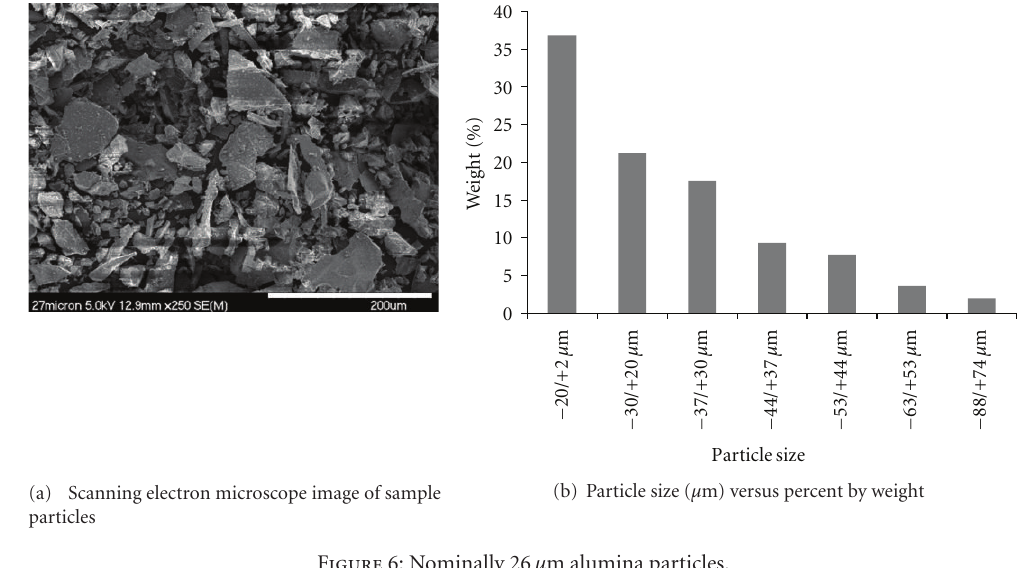
Figure 6: Nominally 26 μ m alumina particles.